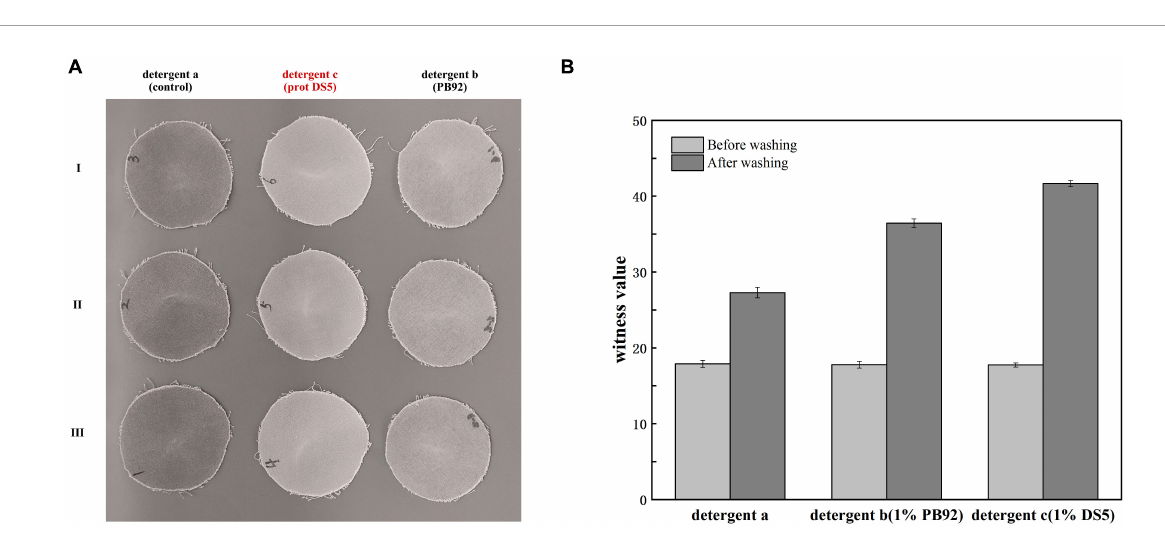
FIGURE9 Determination of washing performance of prot DS5. (A) Visual appearance evaluation of wash performance. (B) Quantitative evaluation of wash performance. Detergent a: 2g Chinese national standard detergent. Detergent b: 2g Chinese national standard detergent + 1% PB92